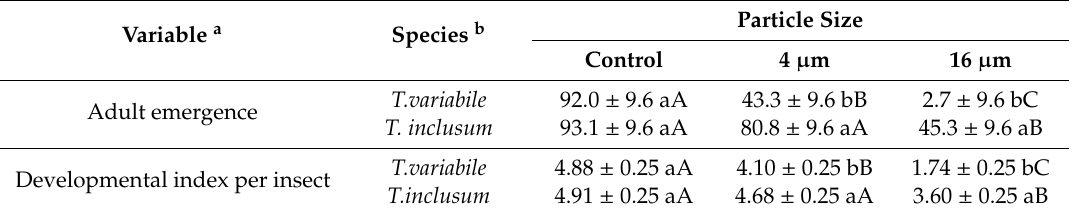
Table 2. Percent adult emergence and developmental index of dermestids in pyrethrin + methoprene aerosol treated concrete arenas after larvae were released in arenas at week one following the application of aerosol and storage of arenas in incubators at di ff erent temperature